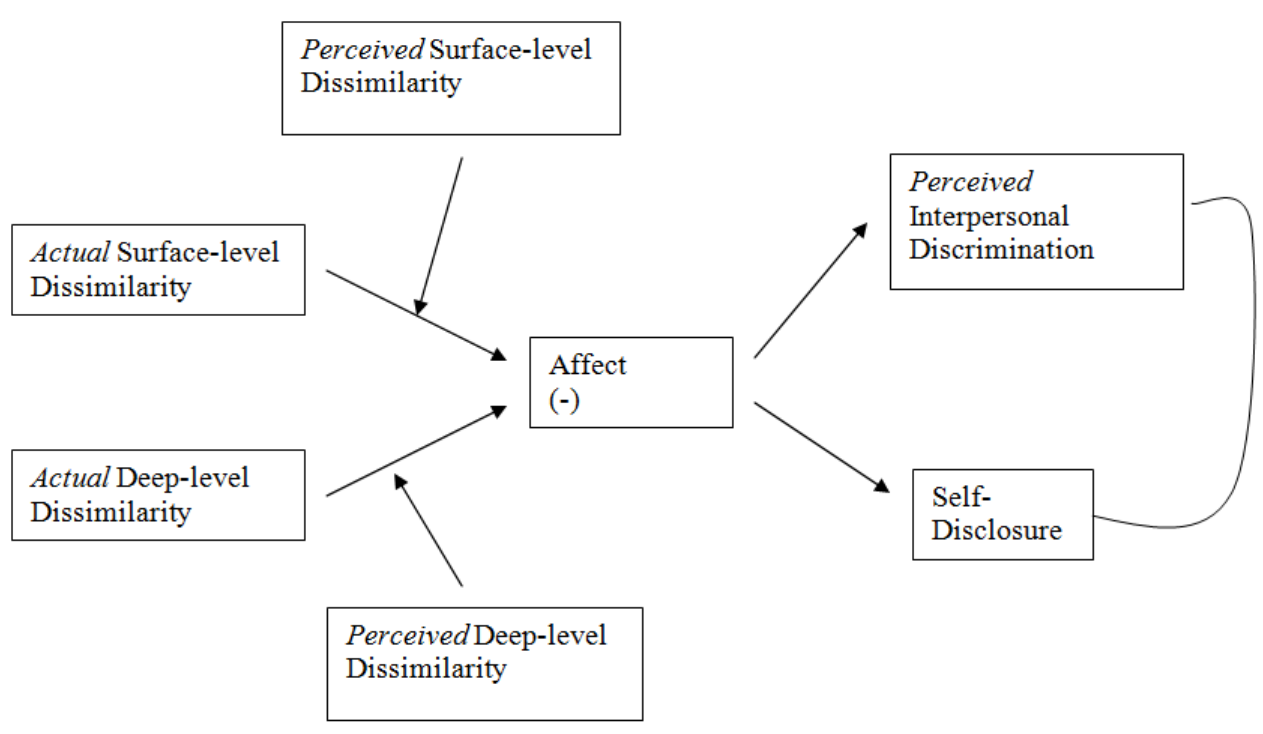
Figure 1. Intervening and Interacting Mechanisms Translating Actual Surface- and Deep-level Employee Dissimilarity into Perceived Discrimination and Self-Disclosure.